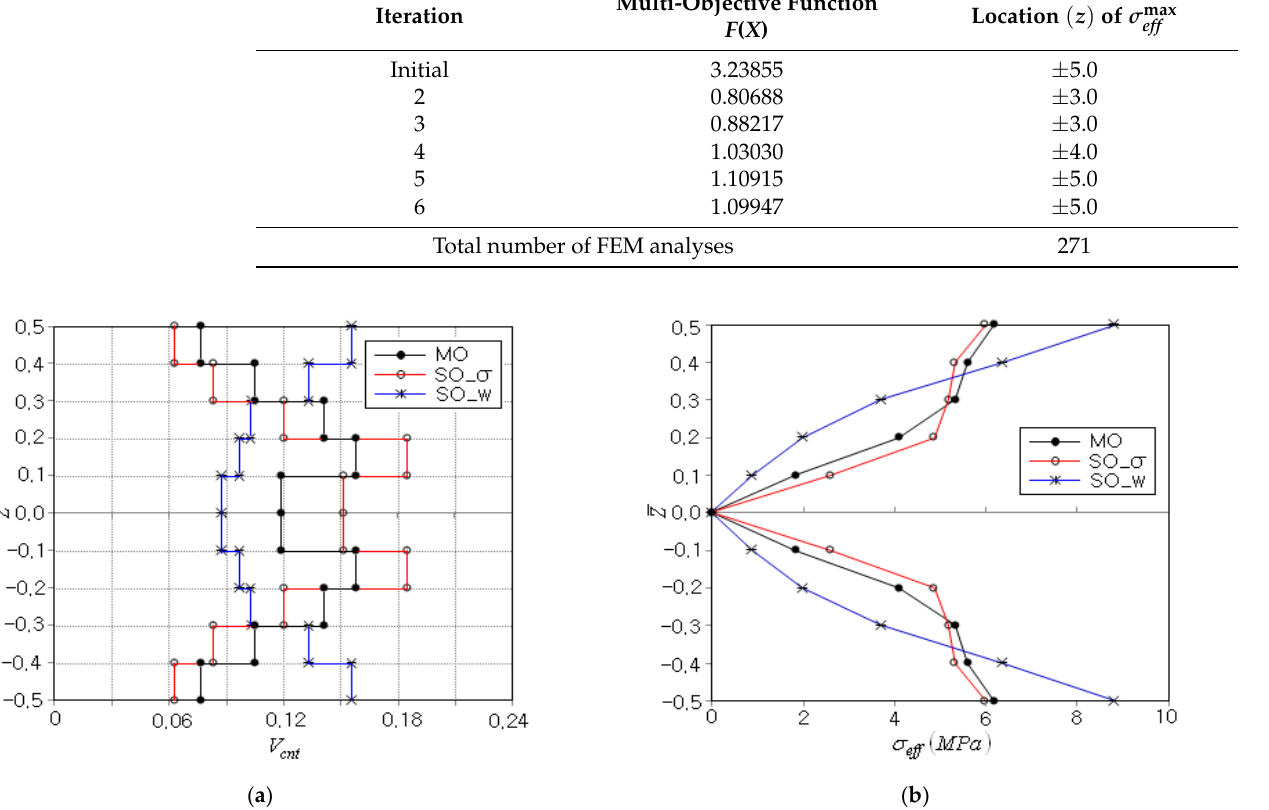
Figure 9. Comparison between MO and SO optimizations: ( a ) optimal CNT distributions, ( b ) thickness-wise effective stress distributions.